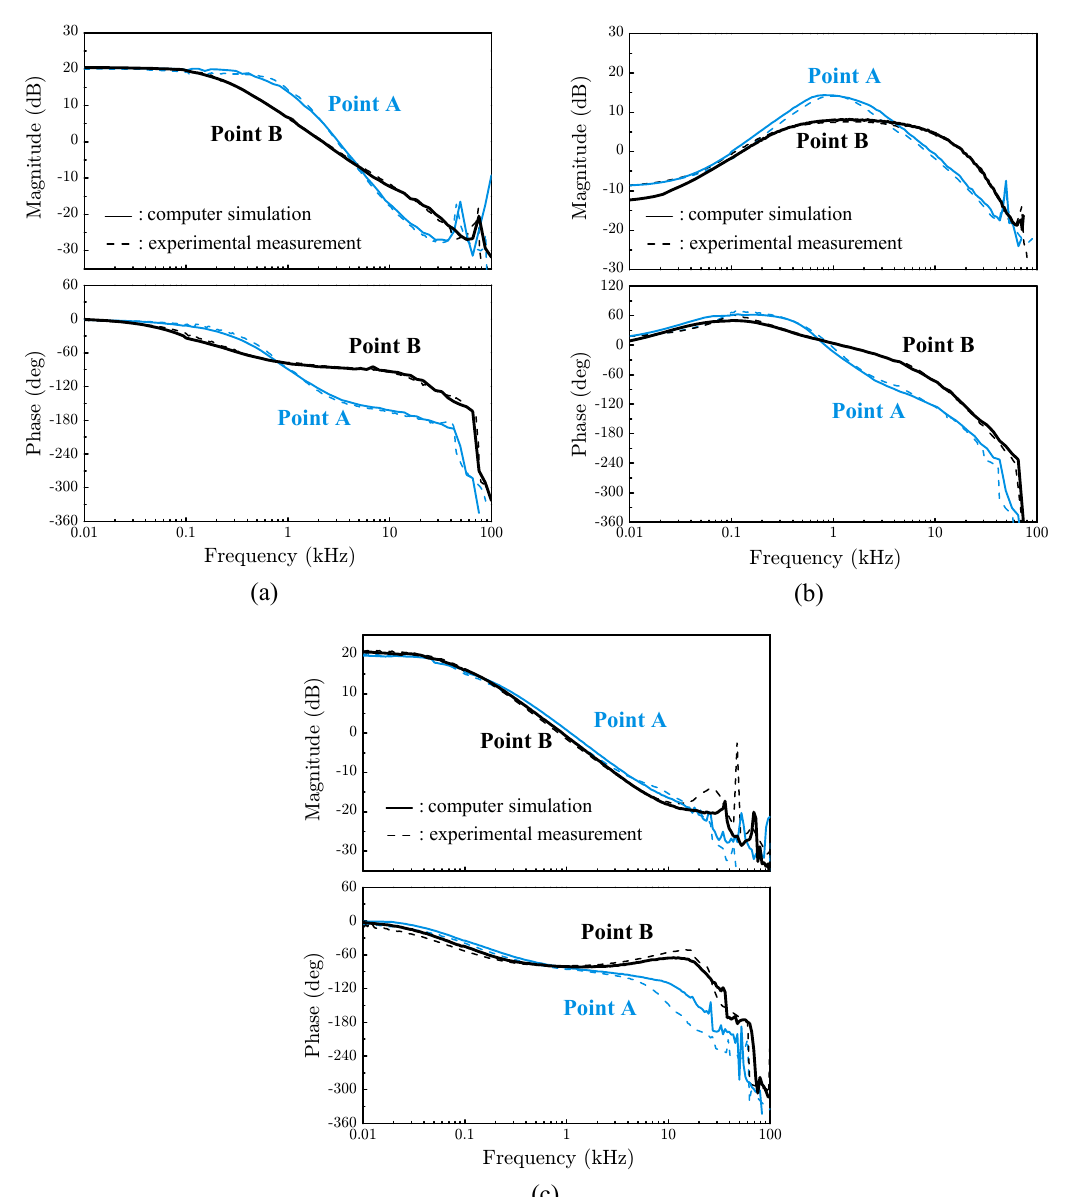
Figure 5. Power stage transfer functions of experimental LLC converter. ( a ) Numerator of Equation (3); ( b ) Denominator of Equation (3); ( c ) Control-to-output transfer function G ( s ) with current mode vci